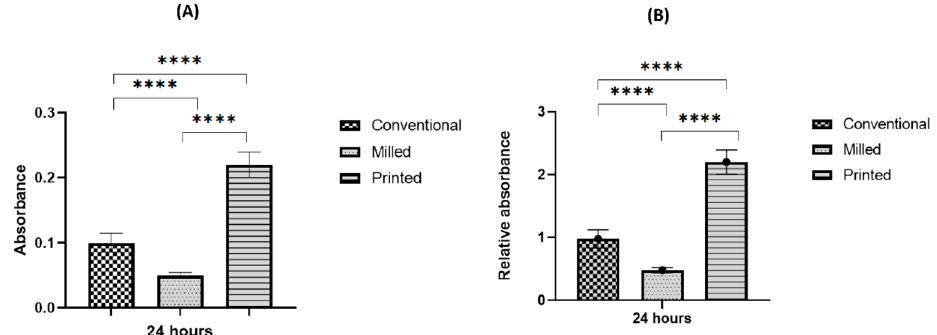
Figure 5. Biofilm assessment on conventional, milled, and 3D-printed groups. Average absorbance obtained with the XTT assay for C. albicans adhered for 24 h ( A ), and relative absorbance obtained with the XTT assay for C. albicans adhered for 24 h ( B ). Significance level is indicated by asterisks (**** p < 0.001). The data display the mean of either absorbance or relative absorbance.